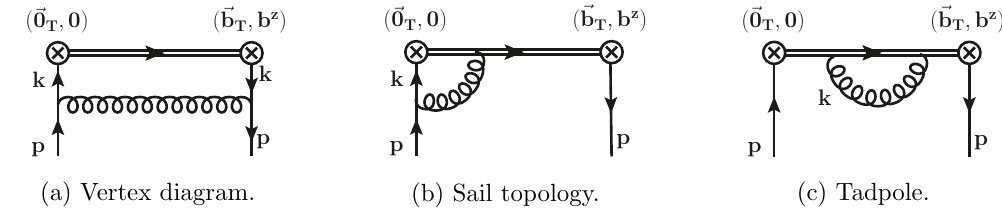
Figure 4. One-loop diagrams contributing to the quasi-TMD beam function of eq. (2.15) in Feynman gauge. Mirror diagrams are not shown. The double line represents the Wilson line W @